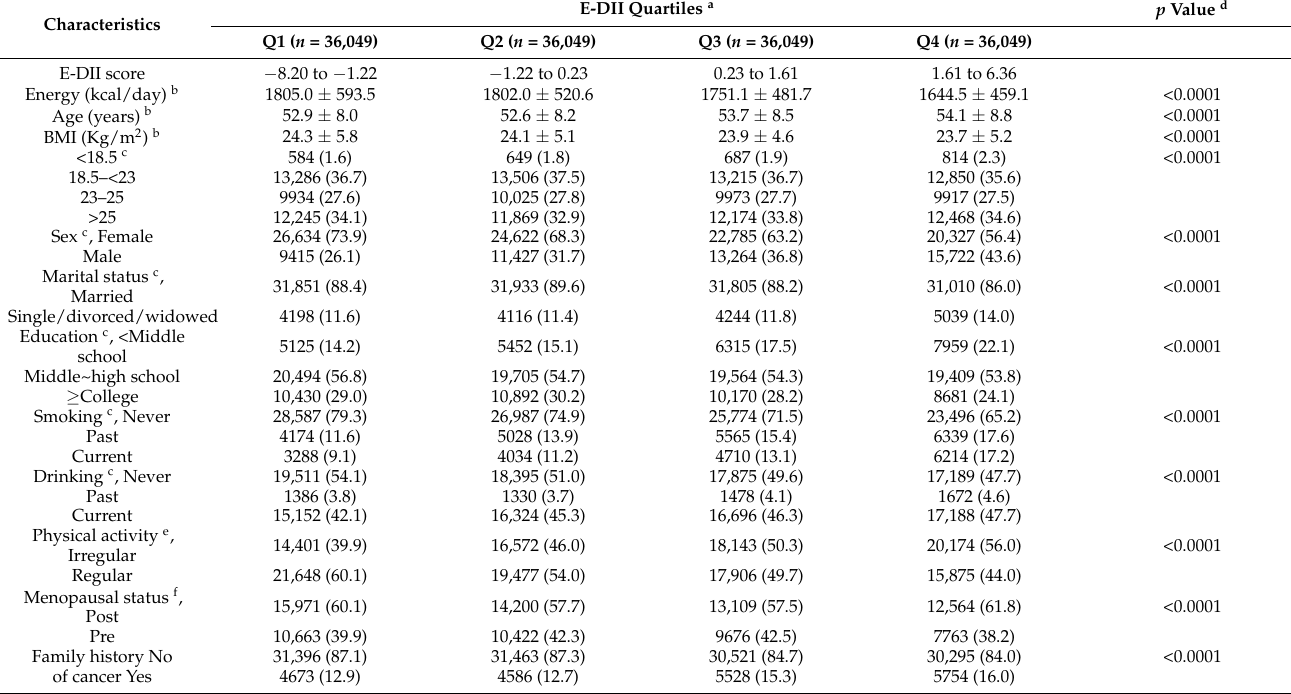
Table 1. Baseline characteristics of study subjects across quartiles of E-DII in KoGES_HEXA ( n =